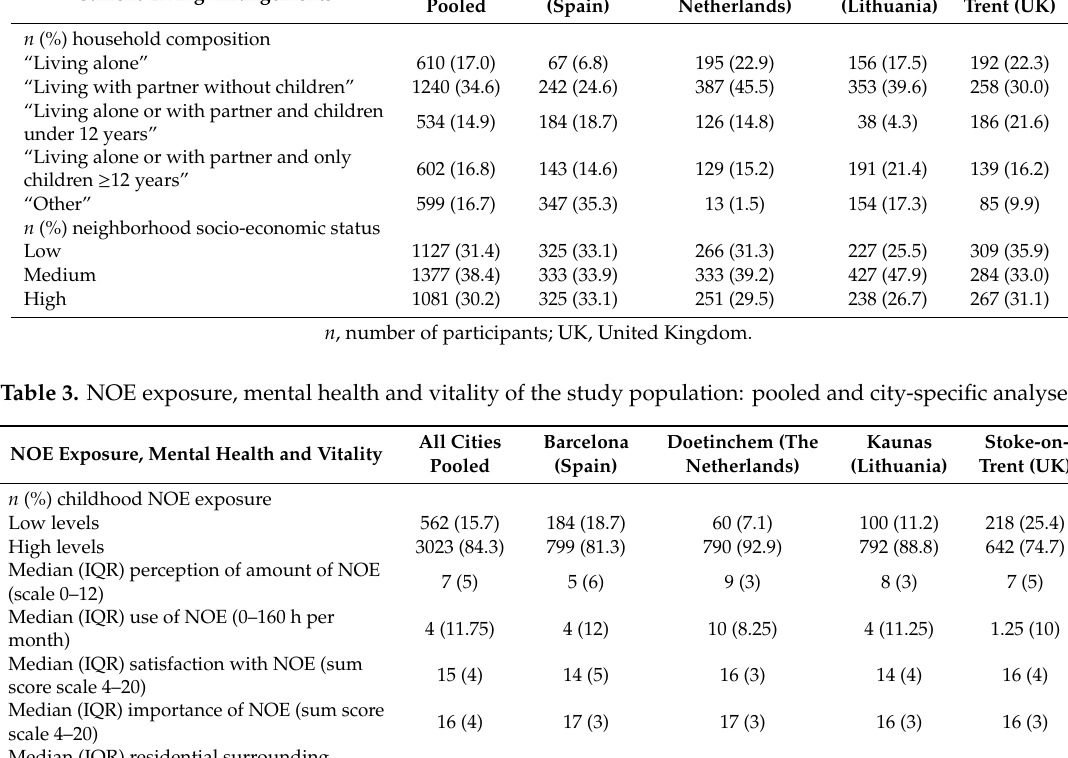
Table 2. Current living arrangements of the study population: pooled and city-specific analyses. Current Living Arrangements